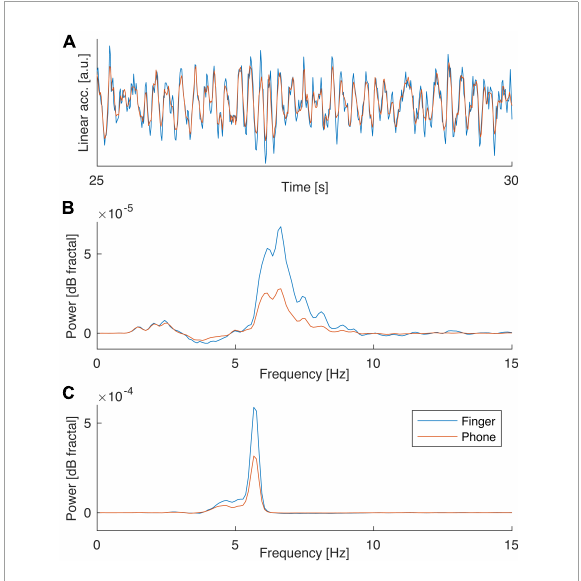
FIGURE3 Direct comparison of finger-attached sensor to smartphone accelerometry. (A) Example recordings from finger/smartphone sensors performed in parallel in an ET patient. (B) Power spectral density of postural tremor data obtained in the two positions (P1/P2) with the two sensors. Note the great resemblance in spectral contents suggesting the main difference is a difference in signal-to-noise (the ratio in peak value over background for finger to phone sensor were 2.4 and 1.9 respectively for P1 and